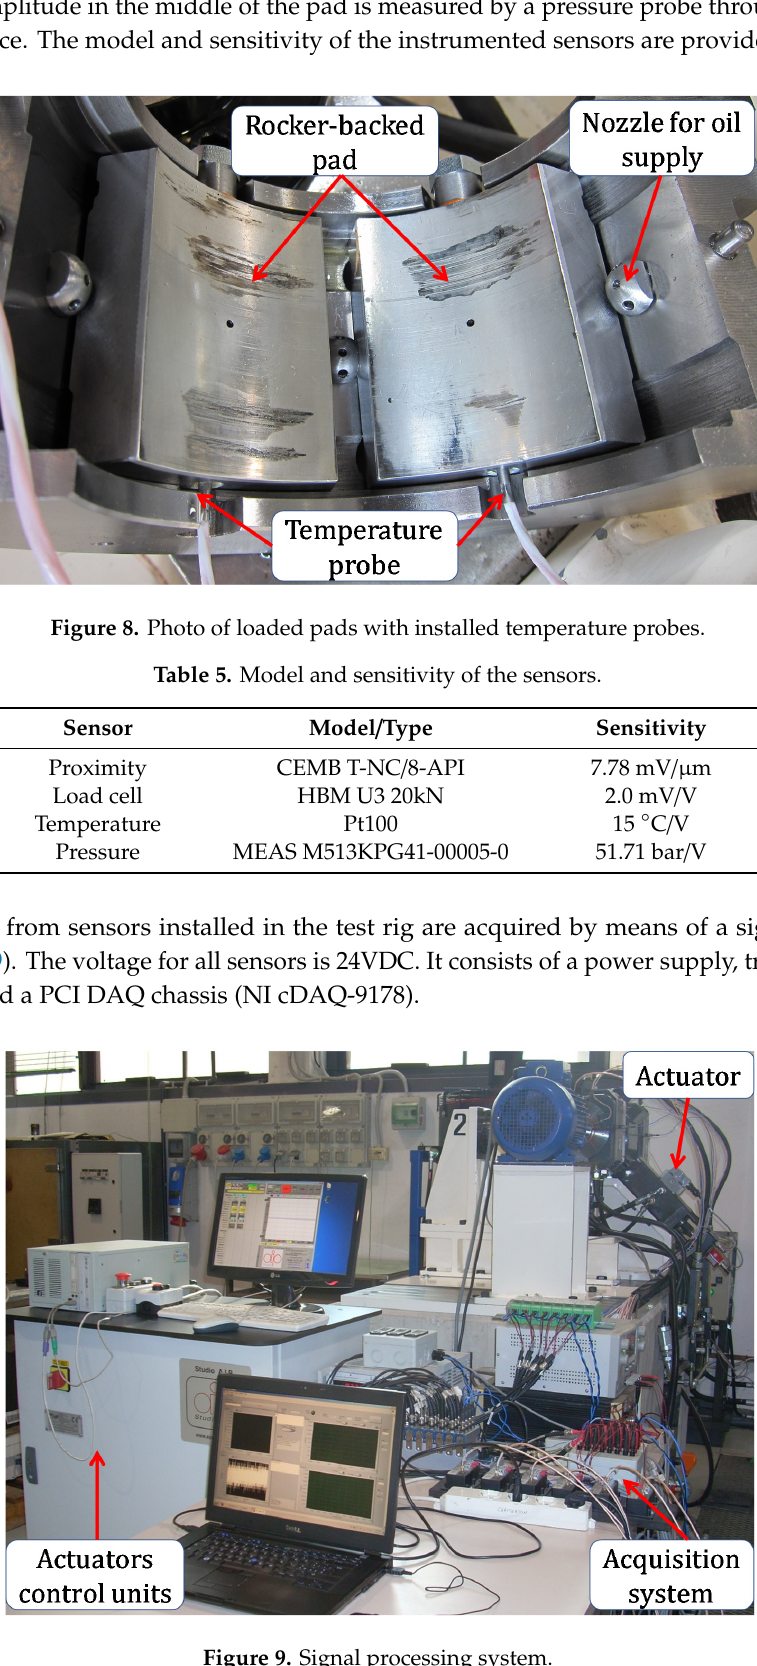
Figure 10. Sketch and dimension of one pad in a TPJB. All the bearing geometric characteristics and the operating conditions are listed in Table 6.